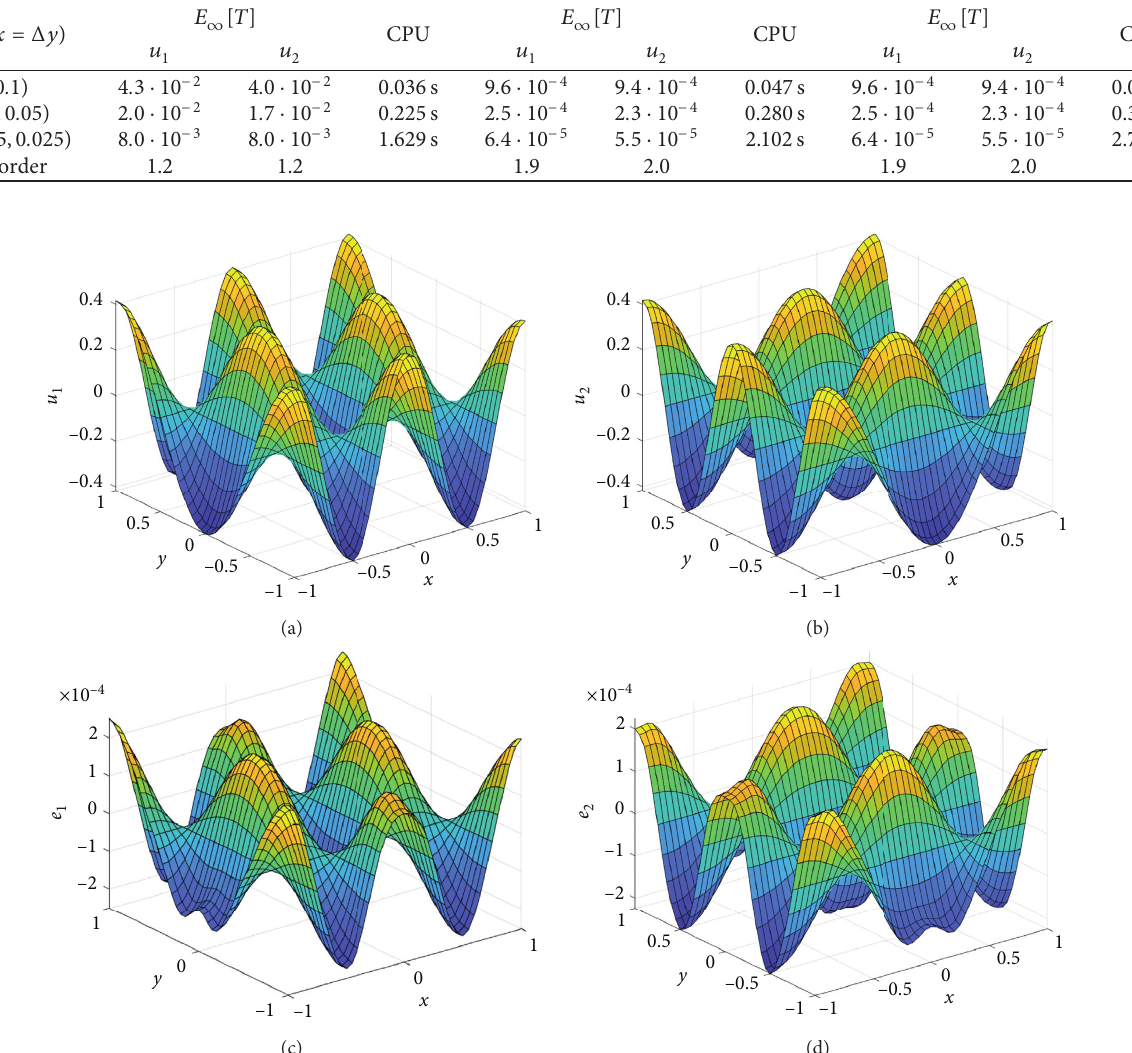
Figure 8: The numerical solution of the variable- θ method and its error at T � 1 . 0 for the Gray–Scott model, when Δ t � 0 . 025 and Δ x � Δ y � 0 . 05: (a) u